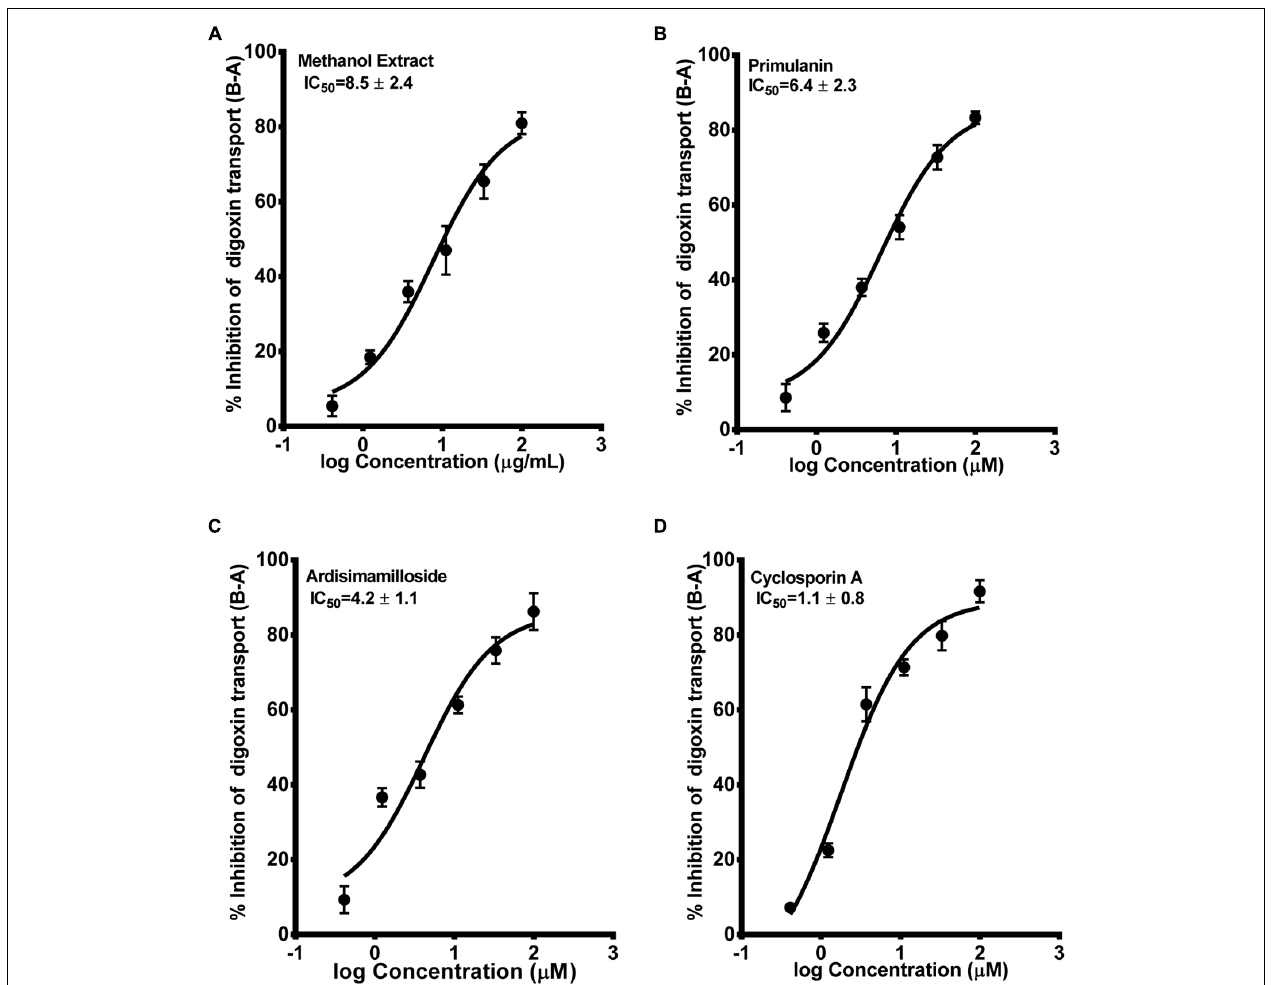
FIGURE 6 | Dose-response curves of P-gp inhibition by methanol extract (A) of Labisia pumila roots, its two saponin constituents (B–C) and positive control cyclosporinA (D), determined by calculating the basolateral to apical transport (%) of 3 H-digoxin across hMDR1-MDCKII cell monolayers. The data are represented as mean ± SD of 3 independent experiments ( n = 1 in each